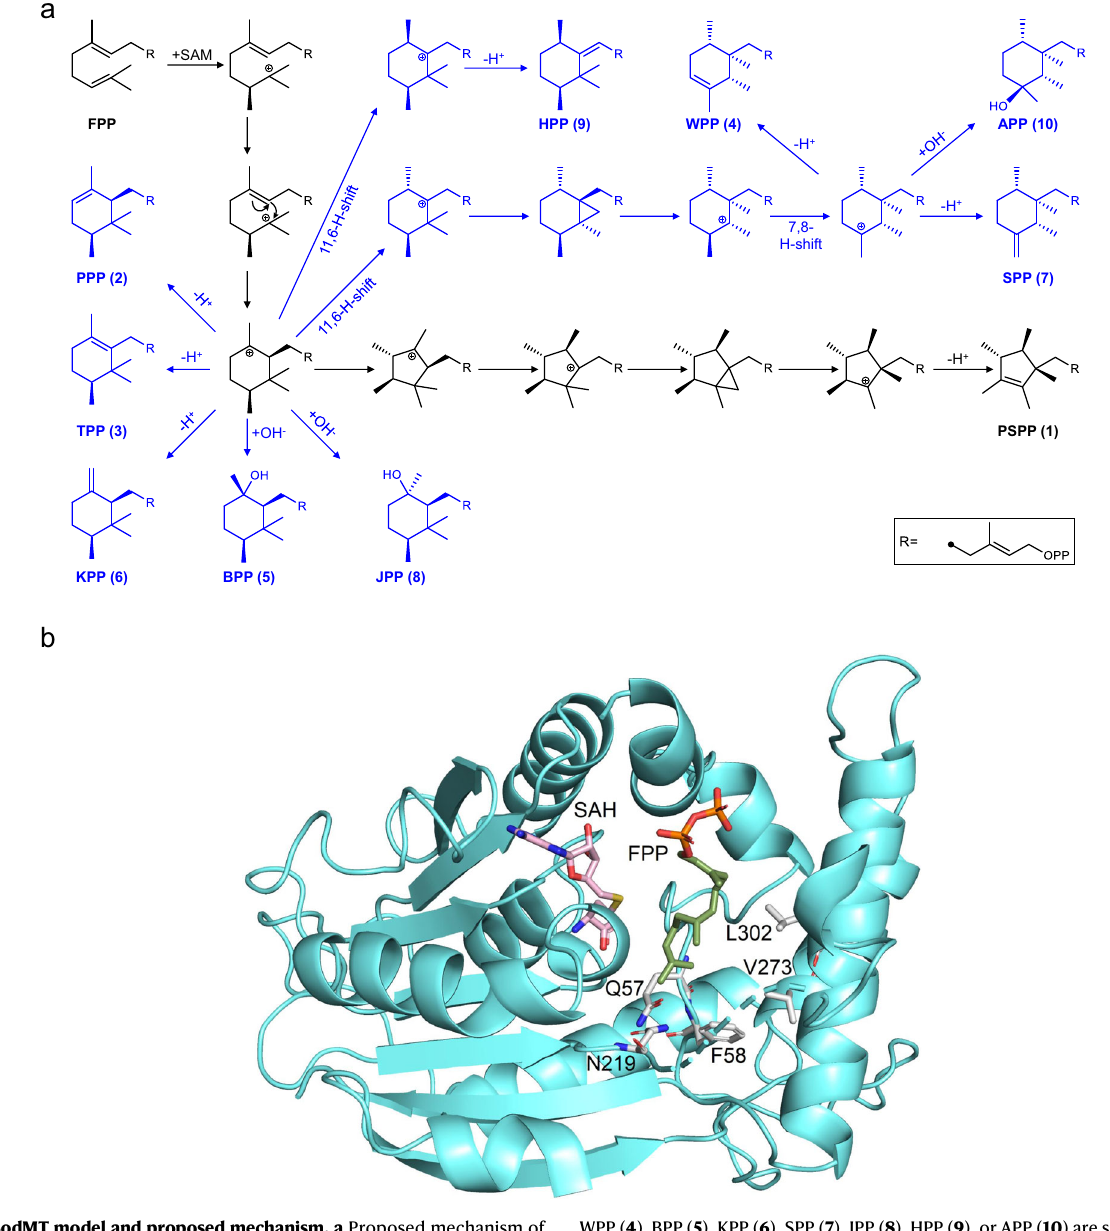
WPP ( 4 ), BPP( 5 ),KPP ( 6 ), SPP ( 7 ),JPP ( 8 ), HPP ( 9 ), or APP( 10 )are shownin blue. b Model of Sp SodMT with FPP and S-adenosyl-L-homocysteine (SAH). Key residues lining the cavity where cyclization of methylated FPP occurs and found to have an impact on product outcome are shown. Graphic constructed with PyMOL (Schrödinger,